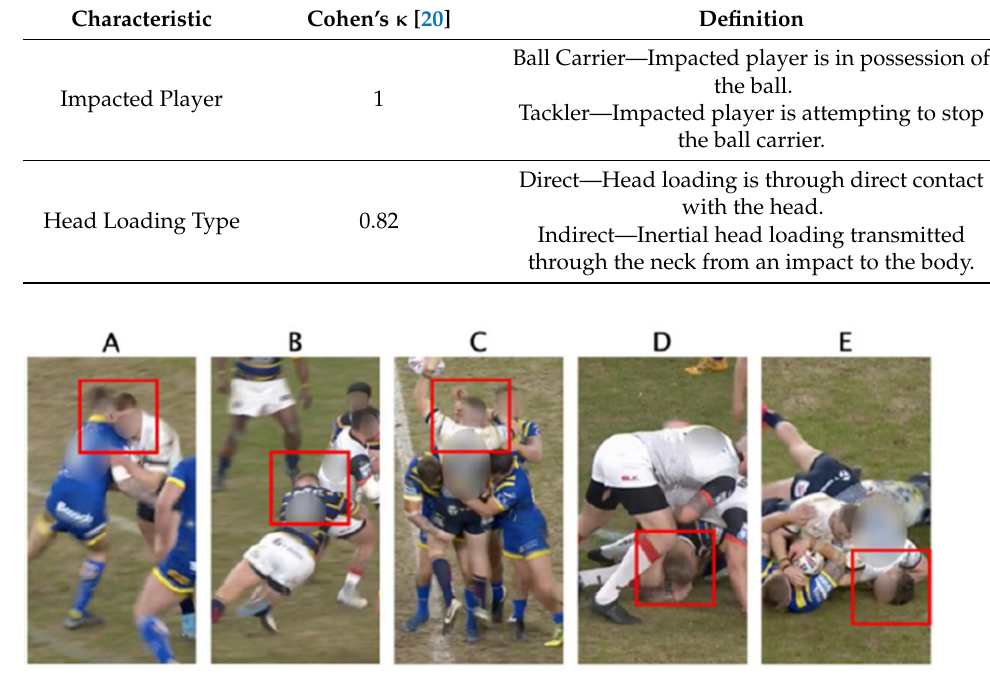
Figure 1. HAE labelled as Initial Collision for a ( A ) carry, ( B ) tackle; ( C ) Secondary Contact, ( D ) Ground Contact and ( E ) Play the Ball for tackle stage, see Table 1 for definitions. An initial tack-le/carry contact between the two impacting players had already been made prior to the arm-to- head HAE pictured in the ( C ) Secondary Contact. Red squares indicate the impacted